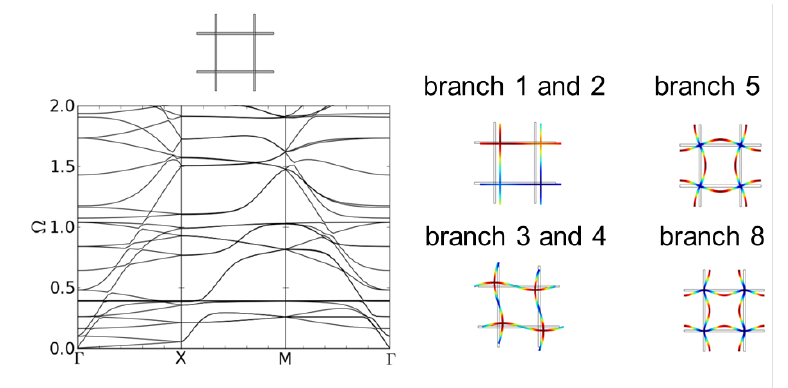
Figure 4. Dispersion relations of structure a-2D, a regular quadratic unit cell (l = 5.0 mm, d = 0.25 mm) and first eigenmodes at point Γ .